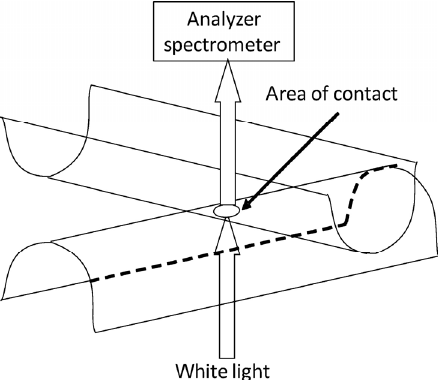
Fig. 2 Sketch of measurement of interfacial forces realized in SFA.